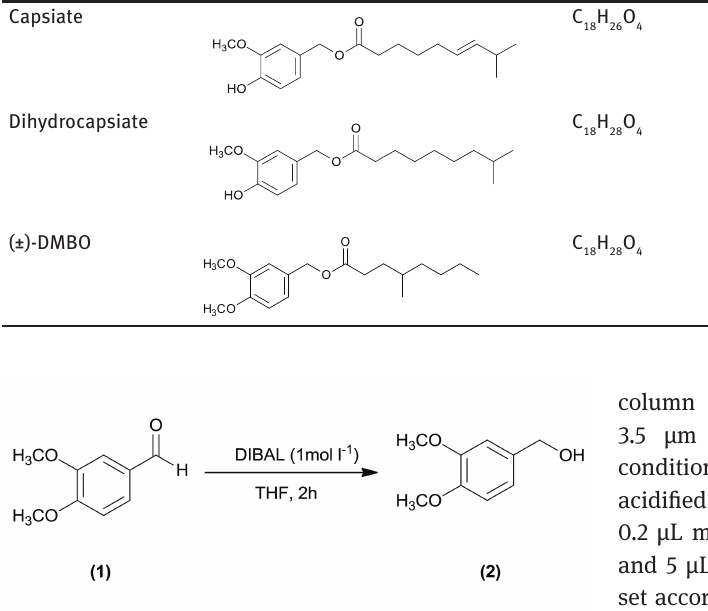
Table 1: Common name, chemical formula, molecular weight, and [M+Na] + of capsiate, (±)-DMBO, and dihydrocapsiate. Common Name